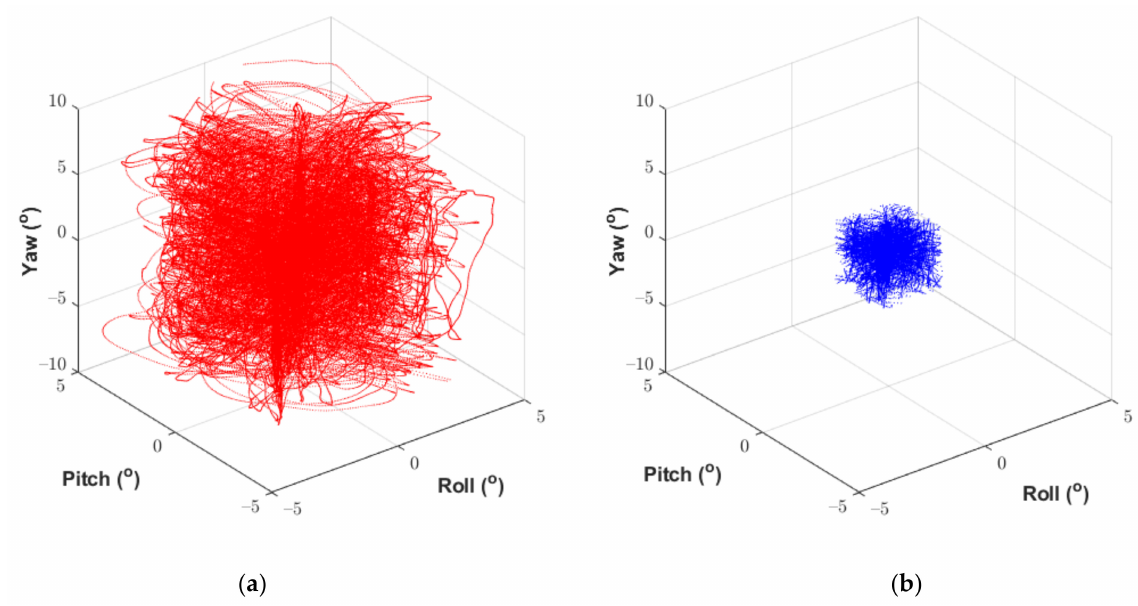
Figure 5. Reference rotation data measured by the FARO arm. ( a ) Full reference dataset for measured rotations at the interface. ( b ) Reduced reference dataset for use during